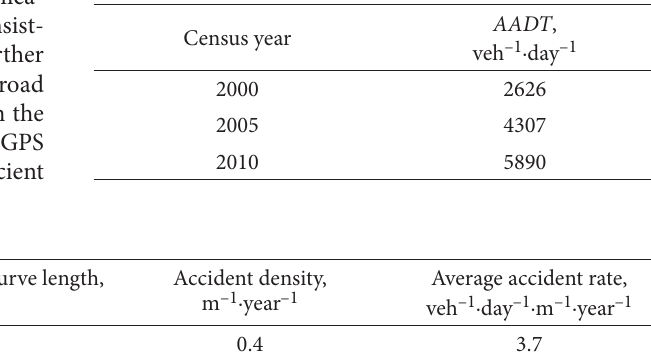
Table 5. Values of AADT on studied route from national traffic census